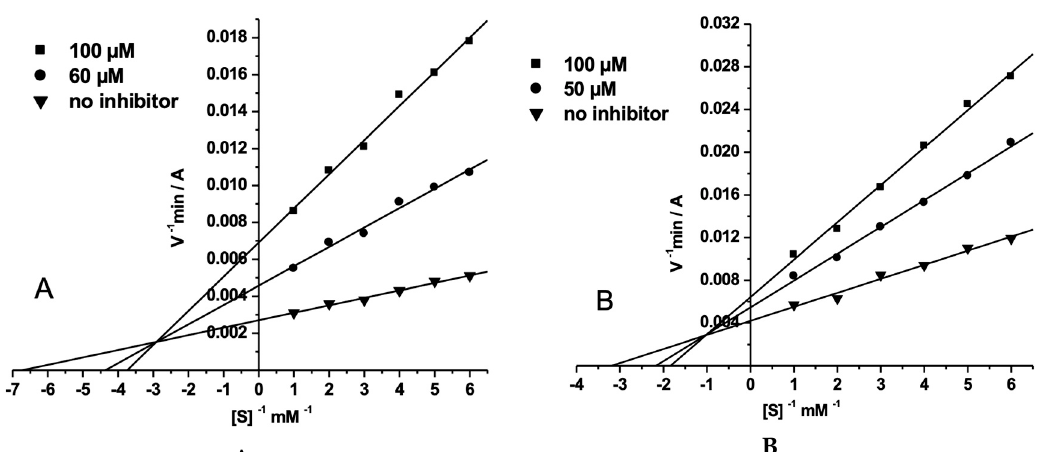
Figure 6. Lineweaver–Burk plots for steady state inhibition of AChE ( A ) and BChE ( B ) by AA- CHOL.